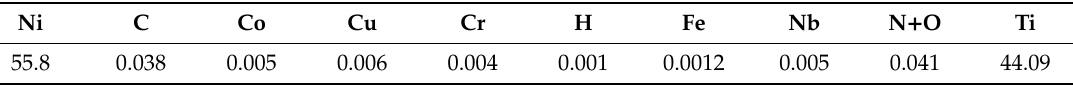
Table 1. The chemical composition of the nickel-titanium (NiTi) shape memory alloy (SMA) (% Weight).